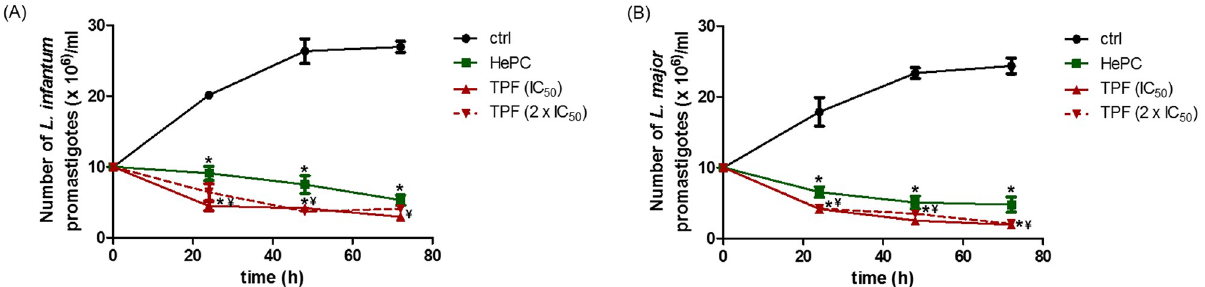
Fig 2. Growth kinetics of Leishmania spp. promastigotes exposed to TPF.